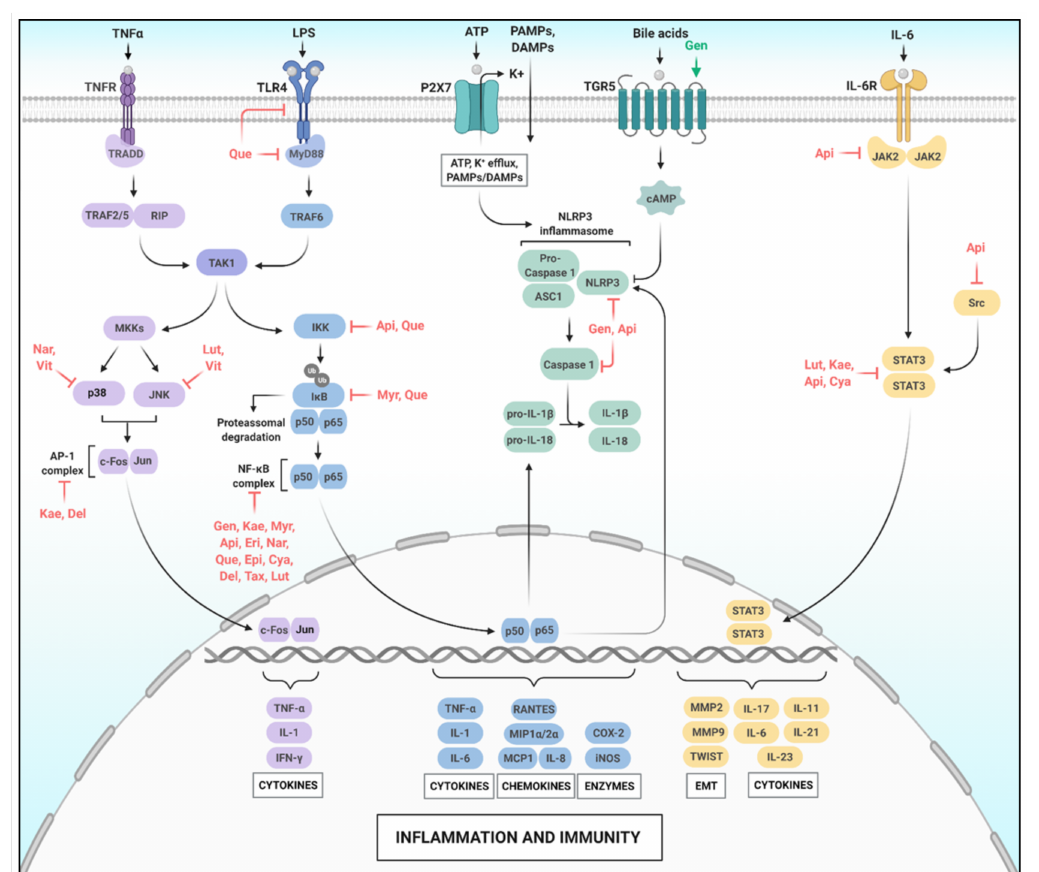
Figure 2. Flavonoids modulate inflammation and immunity pathways in cancer. Pro-inflammatory stimuli like TNF- α and Lipopolysaccharide (LPS) can bind to Tumor Necrosis Factor Receptor (TNFR) and TLR4 receptors, respectively, and activate the TAK1, which is mediated by TNFR-associated Death Domain (TRADD), TRAF2/5, and Receptor-Interacting Protein 1 (RIP) in response to TNF- α /TNFR signaling and Myd88 and TRAF6 in LPS-TLR4 signaling. TAK1 activates Mitogen-Activated Protein Kinases (MKKs) and I Kappa B Kinases (IKKs), leading to translocation of AP-1 and NF- κ B to the nucleus. Flavonoids act mainly in inhibiting the nuclear translocation, expression, or phosphorylation of these transcription factors. The first signal for NLRP3 inflammasome activation is through NF- κ B-mediated transcription of NLRP3. The second signal is mediated by Adenosine Triphosphate (ATP), Pathogen-Associated Molecular Patterns (PAMPs), Damage-Associated Molecular Patterns (DAMPs), and K+ efflux. When NLRP3 inflammasome is activated, caspase 1 cleaves pro IL-18 and pro-IL-1 β in activated forms. Flavonoids act in this pathway mainly by inhibiting caspase 1 activity and reducing the NLRP3 expression. The TGR5-cAMP signaling pathway is activated by Genistein to lead to ubiquitination and degradation of NLRP3. Flavonoids also modulate the JAK2-STAT3 signaling, reducing inflammatory and EMT markers. Epi: Epigallocatechin, Kae: Kaempferol; Myr: Myricetin; Que: Quercetin; Api: Apigenin; Vit: Vitexin; Gen: Genistein; Dai: Daidzein; Lut: Luteolin; Nar: Naringenin; Tax: Taxifolin; Eri: Eriodictyol, Cya: Cyanidin. Original figure made for this review using the Biorender